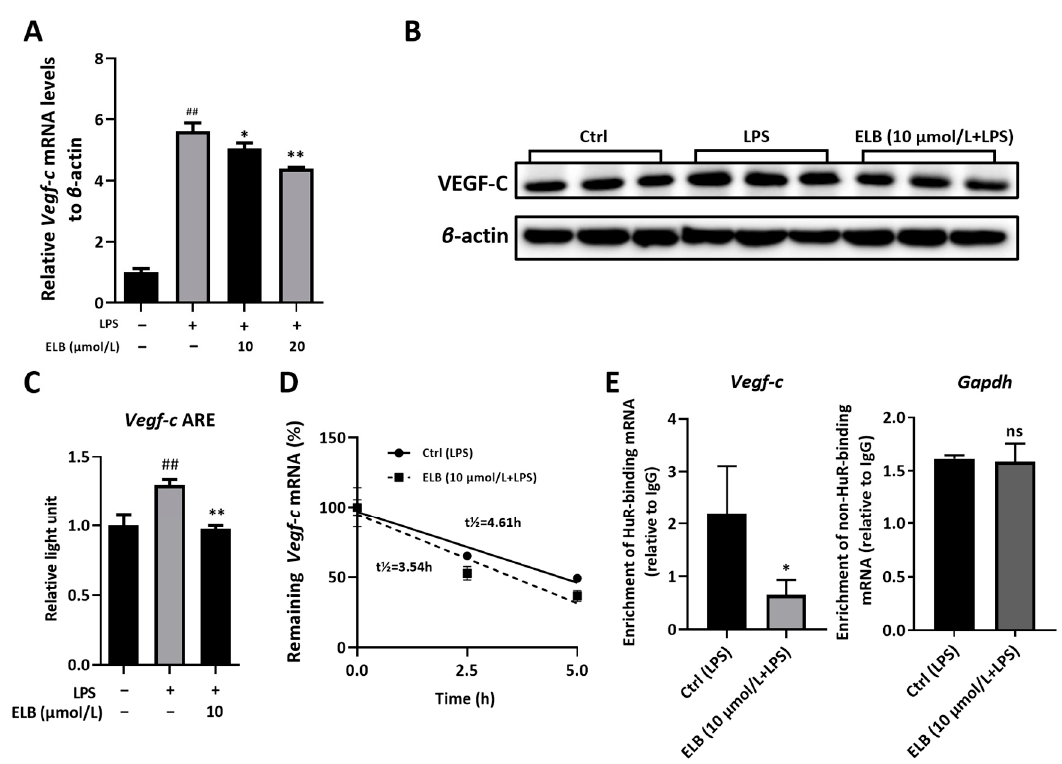
Figure 6. Eltrombopag regulated lymphangiogenesis-related gene in RAW264.7 cells by targeting HuR. ( A ) Relative mRNA level of Vegf-c in RAW264.7 cells impacted by eltrombopag. ( B , C ) Relative protein expression of Vegf-c in RAW264.7 cells impacted by eltrombopag measured with Western blot, representative images and quantitative analyses. ( D ) mRNA stability of Vegf-c in RAW264.7 cells impacted by eltrombopag. ( E ) RIP analysis detected the enrichment of HuR-binding mRNA ( Vegf-c ) and non-HuR-binding mRNA ( Gapdh ) in RAW264.7 cells influenced by eltrombopag. Mean ± SD. n = 3. * p < 0.05 vs. the LPS-treated group, ## p < 0.01 vs. the control group, ** p < 0.01 vs. the LPS-treated group, ns means no significant difference.